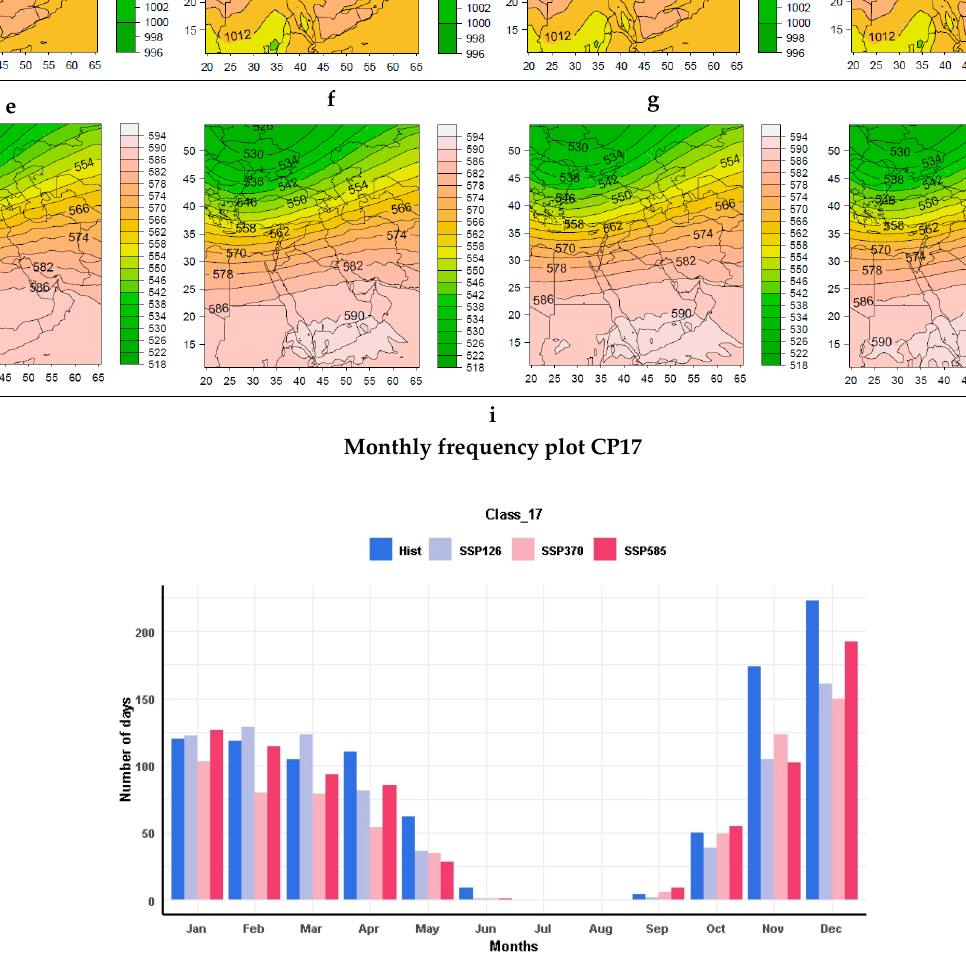
Figure 19. As in Figure 3 for CP17.